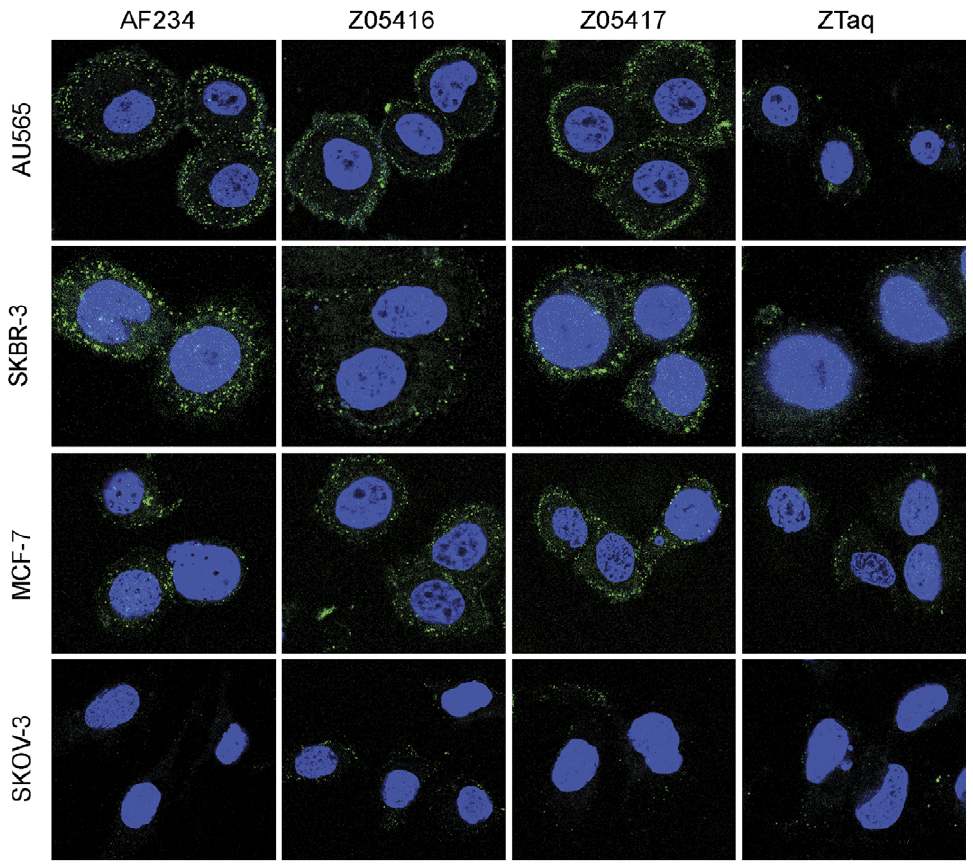
Figure 2. Immunofluorescent staining of human cancer cell lines. Images showing AU565, SKBR-3, MCF-7 and SKOV-3 cells stained with HER3-specific Affibody molecules Z05416 and Z05417, respectively. The polyclonal anti-HER3 antibody A234 and ZTaq were used as positive and negative staining controls, respectively. Affibody molecules and antibodies binding to cells are shown in green while nuclear staining by DAPI is given in blue. AU565 and SKOV-3 images were acquired on the same day using the same detection gain and laser power, enabling comparison between staining intensities. Cell staining of MCF-7 and SKBR-3 was analysed on different days, using different detection gains for optimal image acquisition. Additionally, MCF-7 images were acquired using increased laser power.